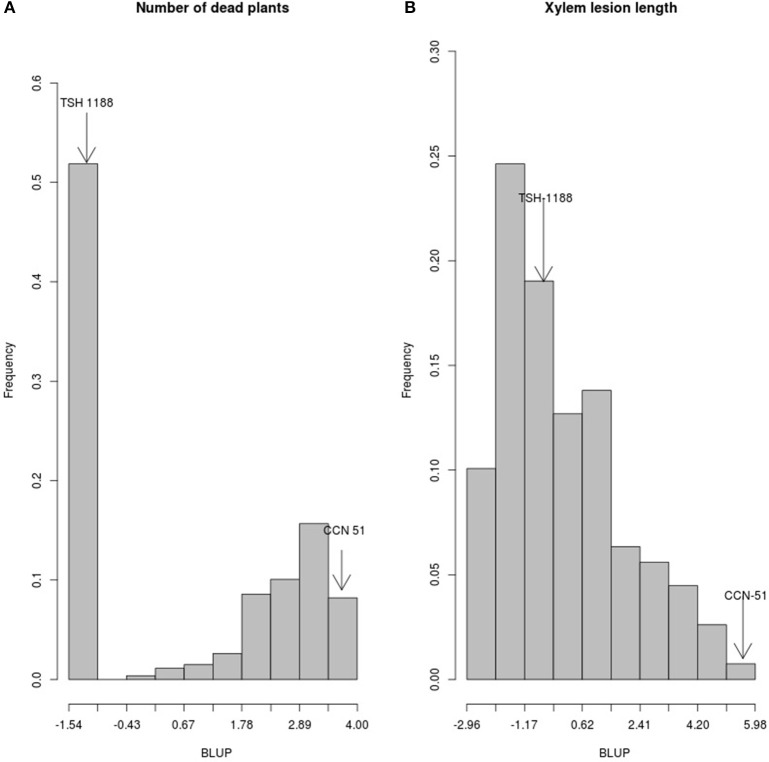
Histogram of frequencies for the numbers of dead plants and xylem lesion length in the F1 population (“TSH 1188” × “CCN 51”). The incidence of Ceratocystis wilt is presented as the number of dead plants showing disease symptoms (A). The severity is shown as the xylem lesion length (B). Values of the parents are indicated.